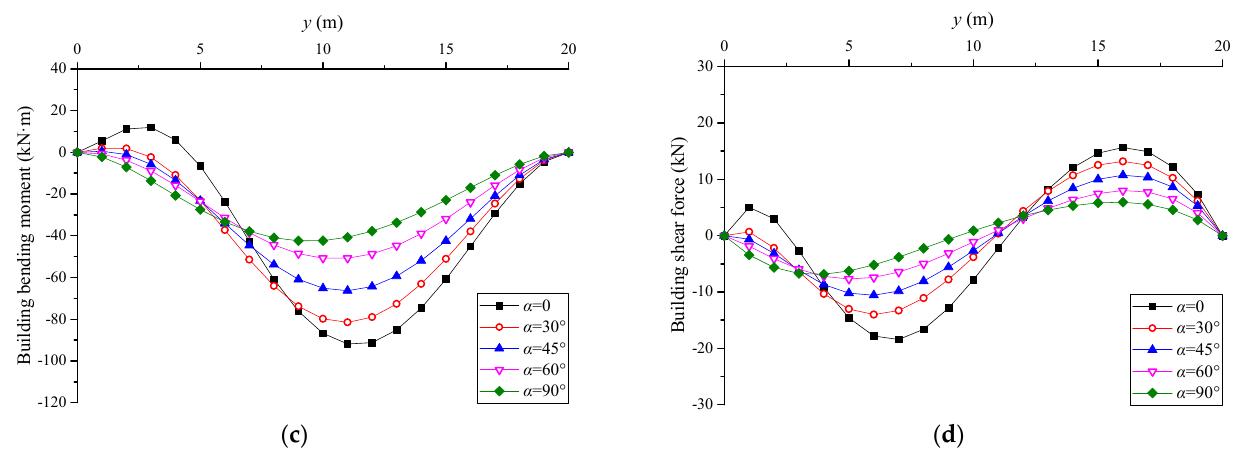
Figure 9. Building response with different alignment angles: ( a ) settlement; ( b ) rotation angle; ( c ) bending moment; ( d ) shear force.